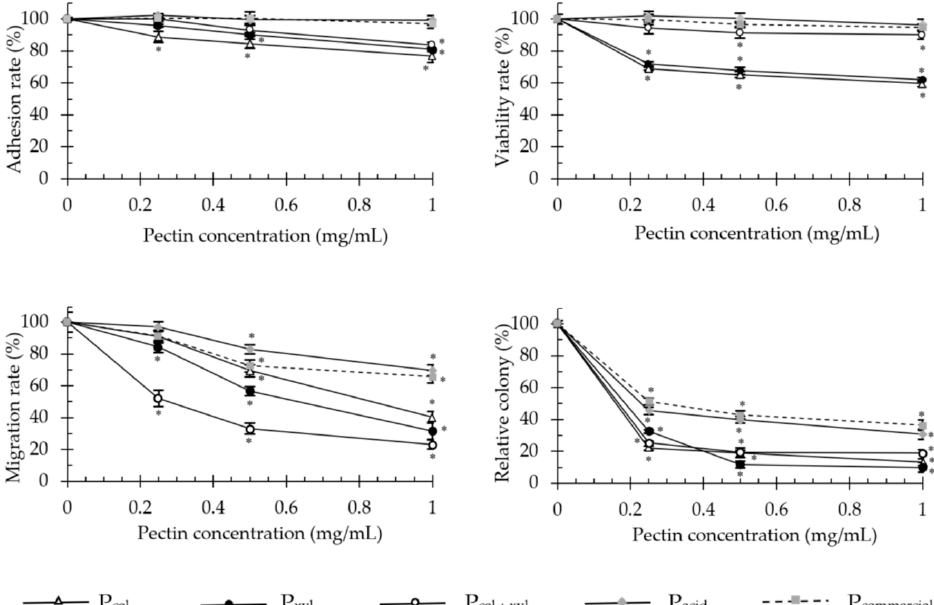
Figure 2. The effect of apple pectins on HT-29 cell proliferation, migration, adhesion and growth in soft agar in vitro. The values represent the means ± SD of cells/colonies (% control). All the experiments were performed thrice in triplicate. * p ˂ 0.001 vs. the control group (Tukey test). P cel —cellulase-extracted pectin; P xyl —xylanase-extracted pectin; P cel + xyl —pectin extracted with both cellulase and xylanase; P commercial —commercial apple pectin.